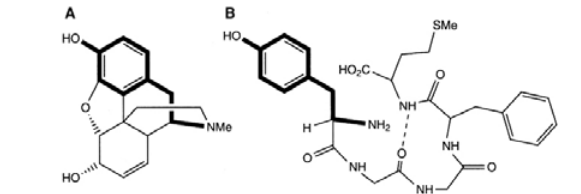
Figure 13. Similarities of the pharmacophoric feature in bold of morphine (A) and [Met 5 ]enkephalin (B).